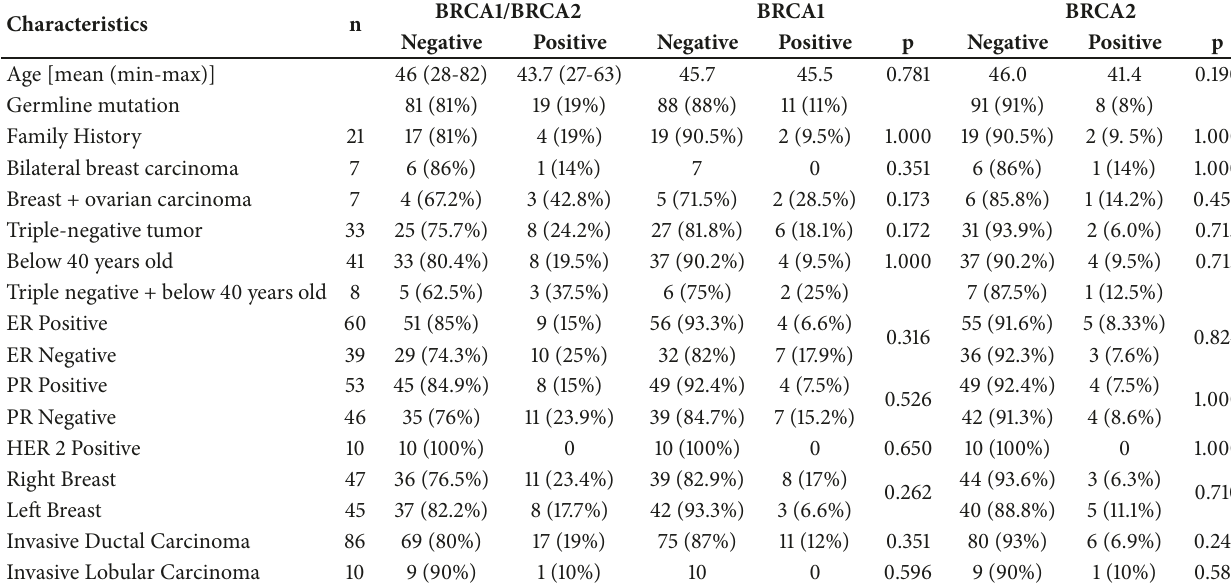
Table 2: The characteristics of the